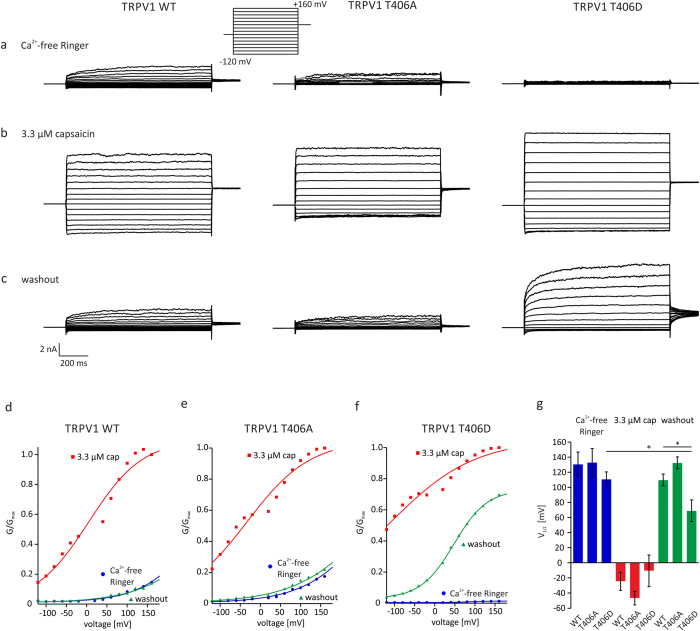
Voltage-dependence of TRPV1 is altered in the T406D mutant.Voltage-dependence of TRPV1WT and TRPV1T406 mutants in transiently transfected CHO cells measured by voltage step protocols with depolarizing pulses from −120 mV to +160 mV. In Ca2+-free ringer solution, voltage-dependent currents are detected in TRPV1WT and TRPV1T406A, but not in TRPV1T406D (a). Application of 3.3 μM capsaicin induces robust voltage-dependent currents in CHO cells expressing TRPV1WT, TRPV1T406A or TRPV1T406D (b). Voltage-activated currents evoked one minute after washout of capsaicin revealed an increased voltage-dependence of TRPV1T406D, whereas the voltage-induced currents of TRPV1WT, TRPV1T406A recover to the same level as under Ringer’s conditions (c). Normalized conductance G/Gmax of n = 6–7 independent measurements of TRPV1WT (d), TRPV1T406A (e), and TRPV1T406D (f). Sigmoidal fit was used to calculate V1/2. Asterisk (*) indicates significant decrease of V1/2 of TRPV1T406D after priming with 3.3 μM capsaicin (paired WR-test, p < 0.05).